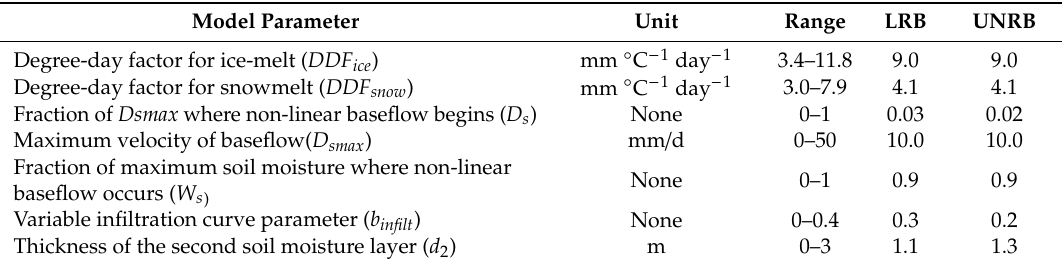
Table 3. The model’s parameter